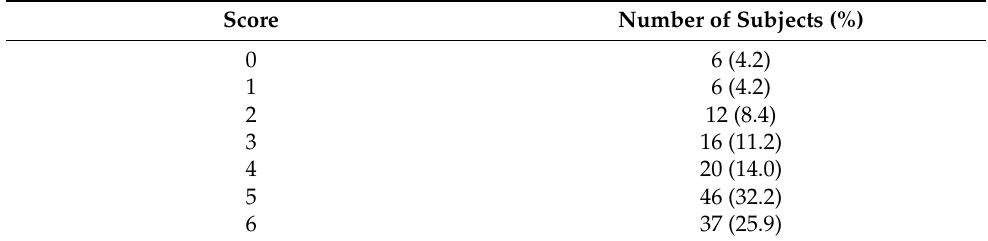
Table 3. Level of loneliness.